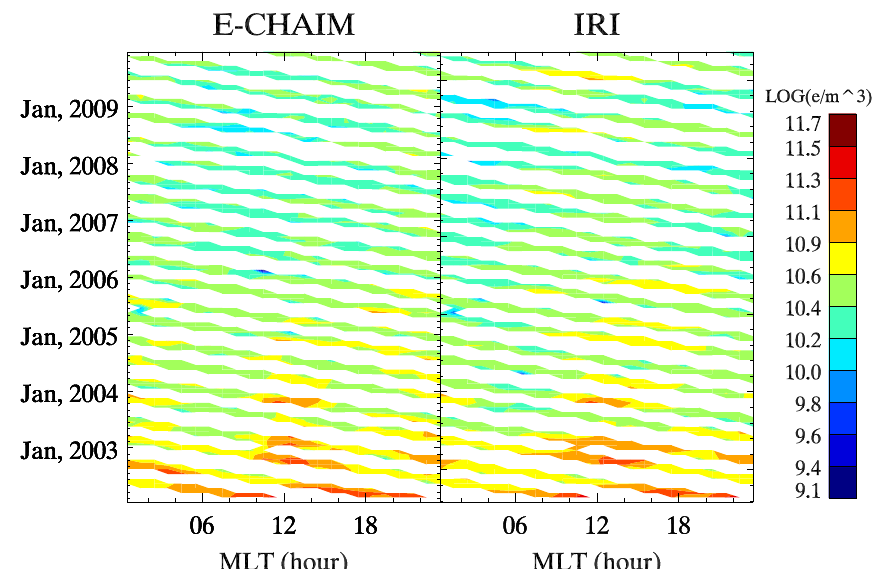
Fig. 16. Log contours of E-CHAIM (left) and IRI (right) monthly RMS electron density errors with respect to CHAMP in situ measurements from a bin between 65 (cid:1) N and 75 (cid:1)